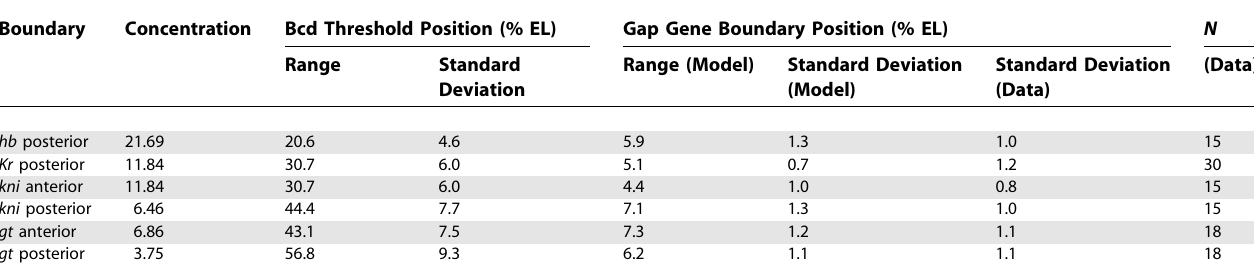
Table 2. Comparison of the Positional Variance of Six Gap Gene Borders with the Positional Variance of Bcd Boundary